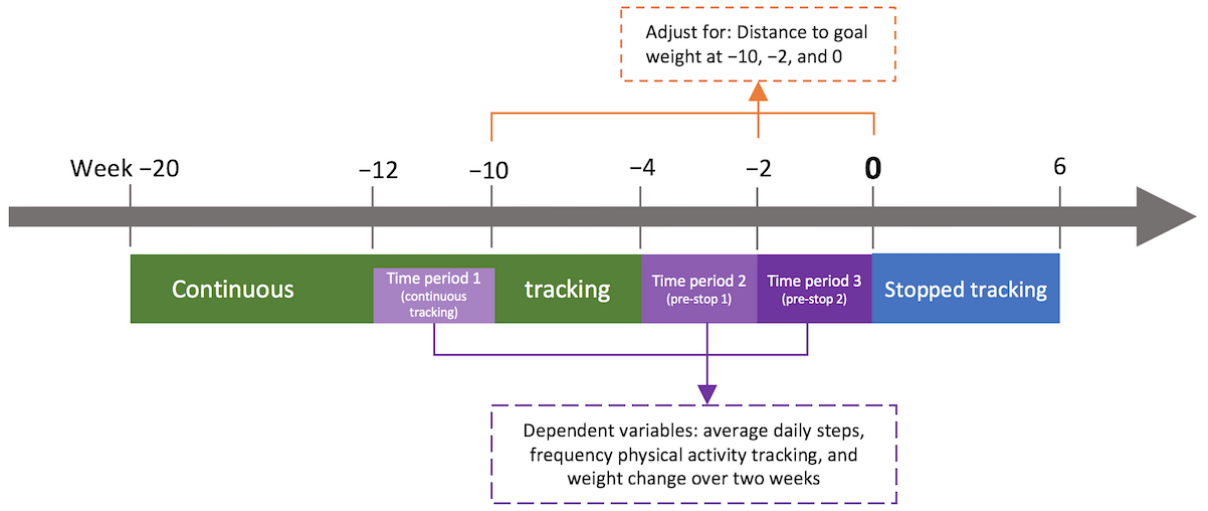
Figure 2. Design of the post hoc analysis, aiming to investigate temporal sequence of